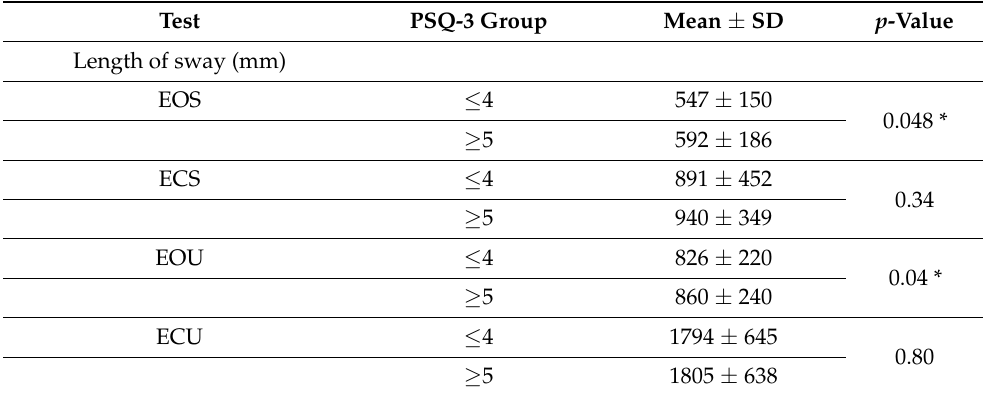
Table 6. Postural control on the force plate for the PSQ-3-FI score ≤ 4 and ≥ 5 groups ( n =